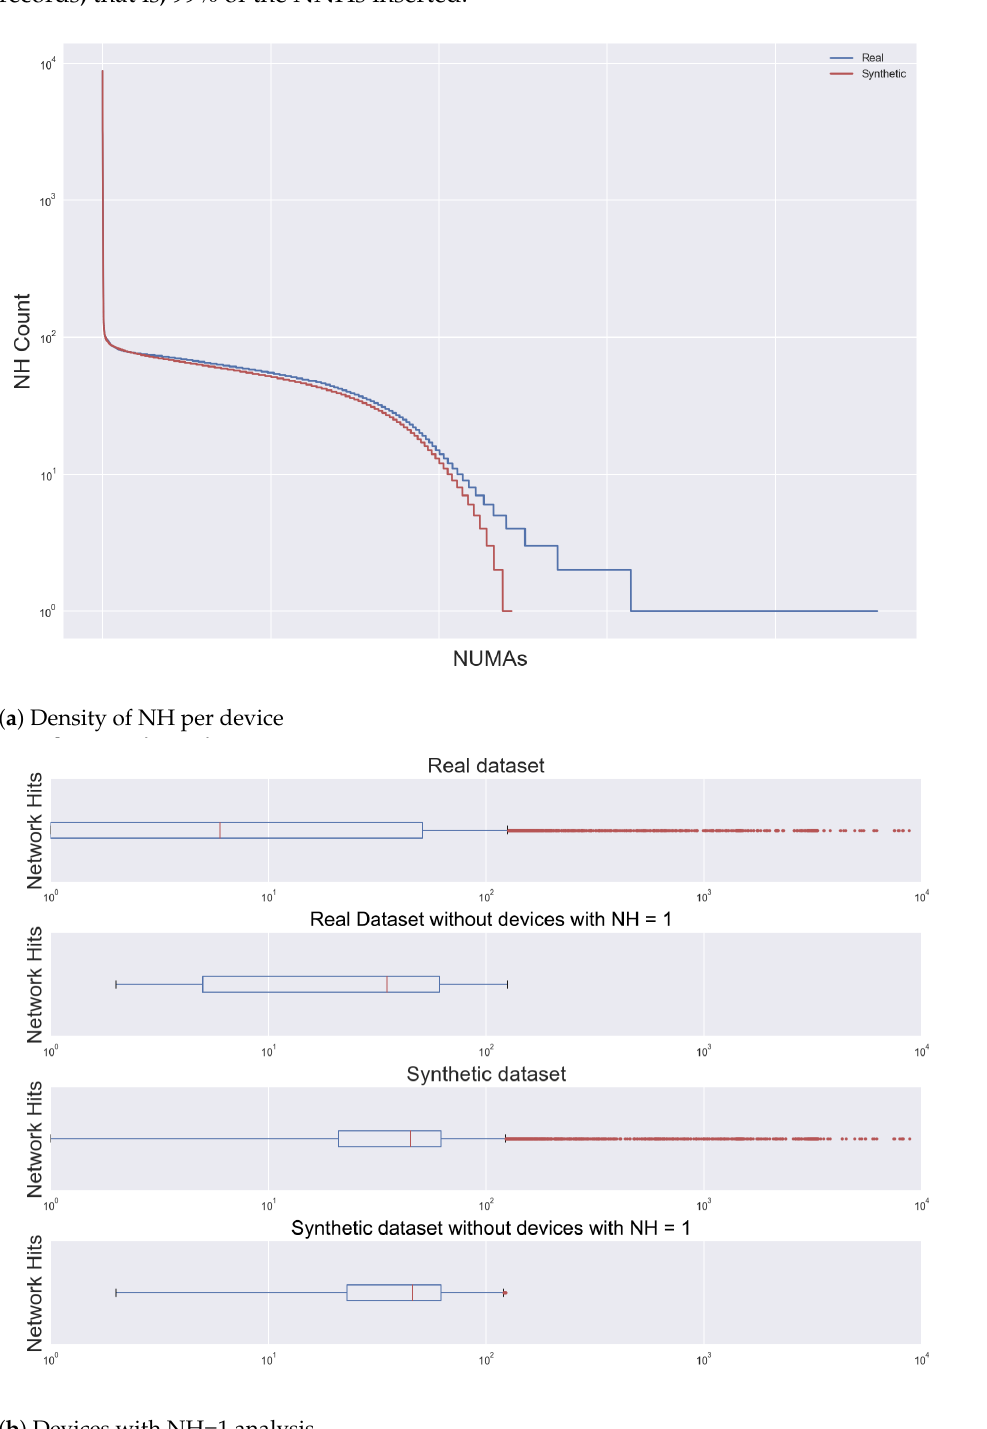
Figure 13. Comparison of statistical behavior between real and synthetic data. Once we confirmed adequate behavior, we introduced controlled noise to evaluate FNFA